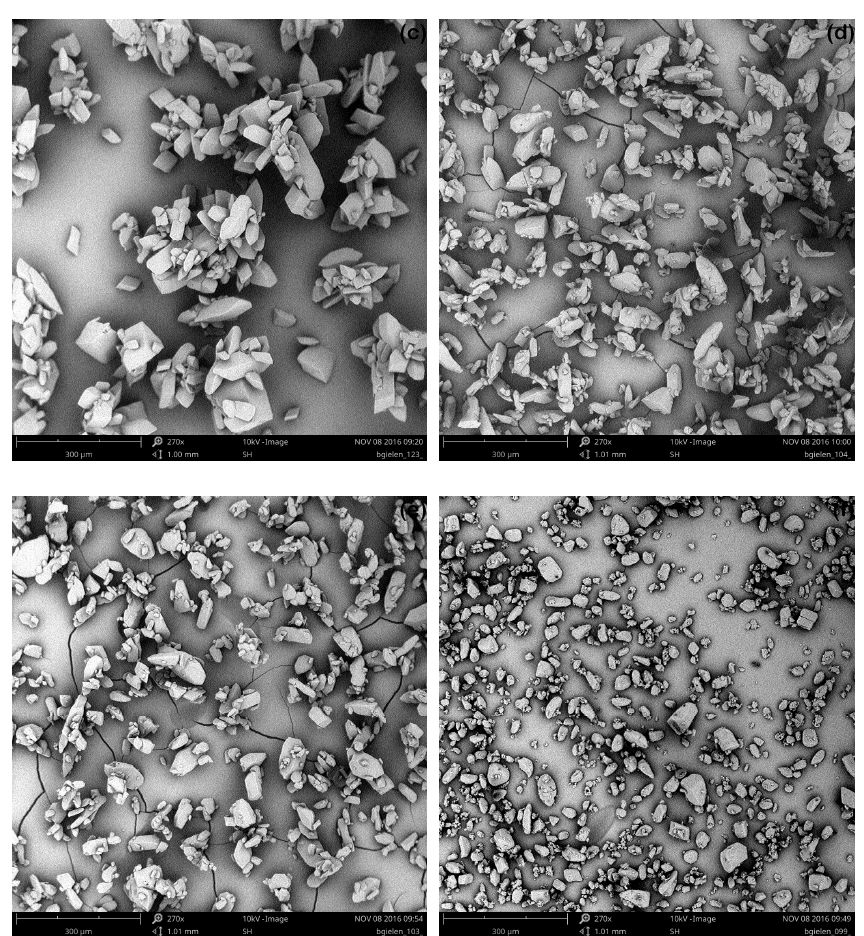
Figure 12. SEM images of crystals resulting from selected experiments displayed in Figure 11 which are used to classify crystals into mono- or star-shaped morphology. The ultrasonic exposure time after nucleation for these images are: ( a ) 0 min; ( b ) 3.25 min; ( c ) 5.75 min; ( d ) 37 min; ( e ) 63.8 min; and ( f ) 317 min. All SEM pictures were magnified 270 times and the scale bar represents a length of 300 µm. In all experiments, the ultrasonic energy was supplied at a constant temperature of 62 °C, corresponding to an initial supersaturation ratio of 3.47. Since a waiting time of 80 min is maintained after addition of seed crystals in the conventional process, a similar time span for application of ultrasound was evaluated. Within this window, the FBRM shows a similar response as discussed before during spontaneous nucleation at 57 °C (Figure 7b). After the initial low-response phase, the total counts sharply rise with increasing exposure time to the ultrasonic field and start to level off at around 25,000 counts. Furthermore, this plot indicates that a sufficient exposure time to the ultrasonic field, yielding a total FBRM count close to the plateau value, will predominantly result in mono-crystals (zone II), while agglomeration occurs by application of shorter sonication periods (zone I). Although some degree of agglomeration still occurs, especially for the smallest crystals, the reduced presence of the star-shaped morphology for large particles is clearly noticeable when sonication is maintained until 25,000 FBRM counts are reached. Finally, the use of continuous ultrasound throughout the entire crystallization process (indicated by an exposure time of 317 min) is also evaluated as a mean of comparison. Similarly as the tests with the use of pulsed ultrasound during the entire process (Figure 9), this method produces mostly mono-crystals with a strongly reduced size compared to the conventional process.